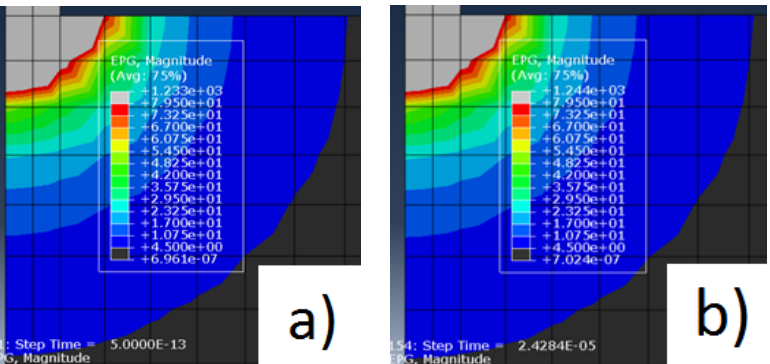
Figure 6. ( a ) Electrical potential gradient for the pulse of 320 µ s at the beginning of the discharge; ( b ) Electrical potential gradient for the pulse of 320 µ s at the end of the